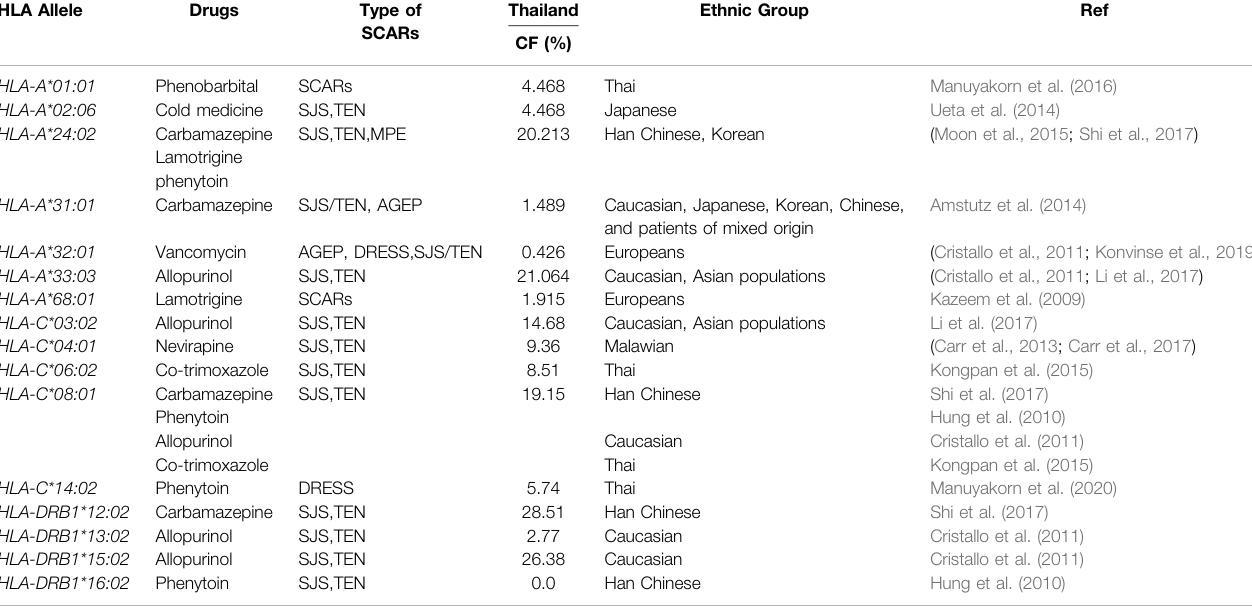
TABLE 2 | The HLA alleles associated with SCARs and carrier frequency of Thai population (N = 470) from published article (Satapornpong et al., 2020). HLA